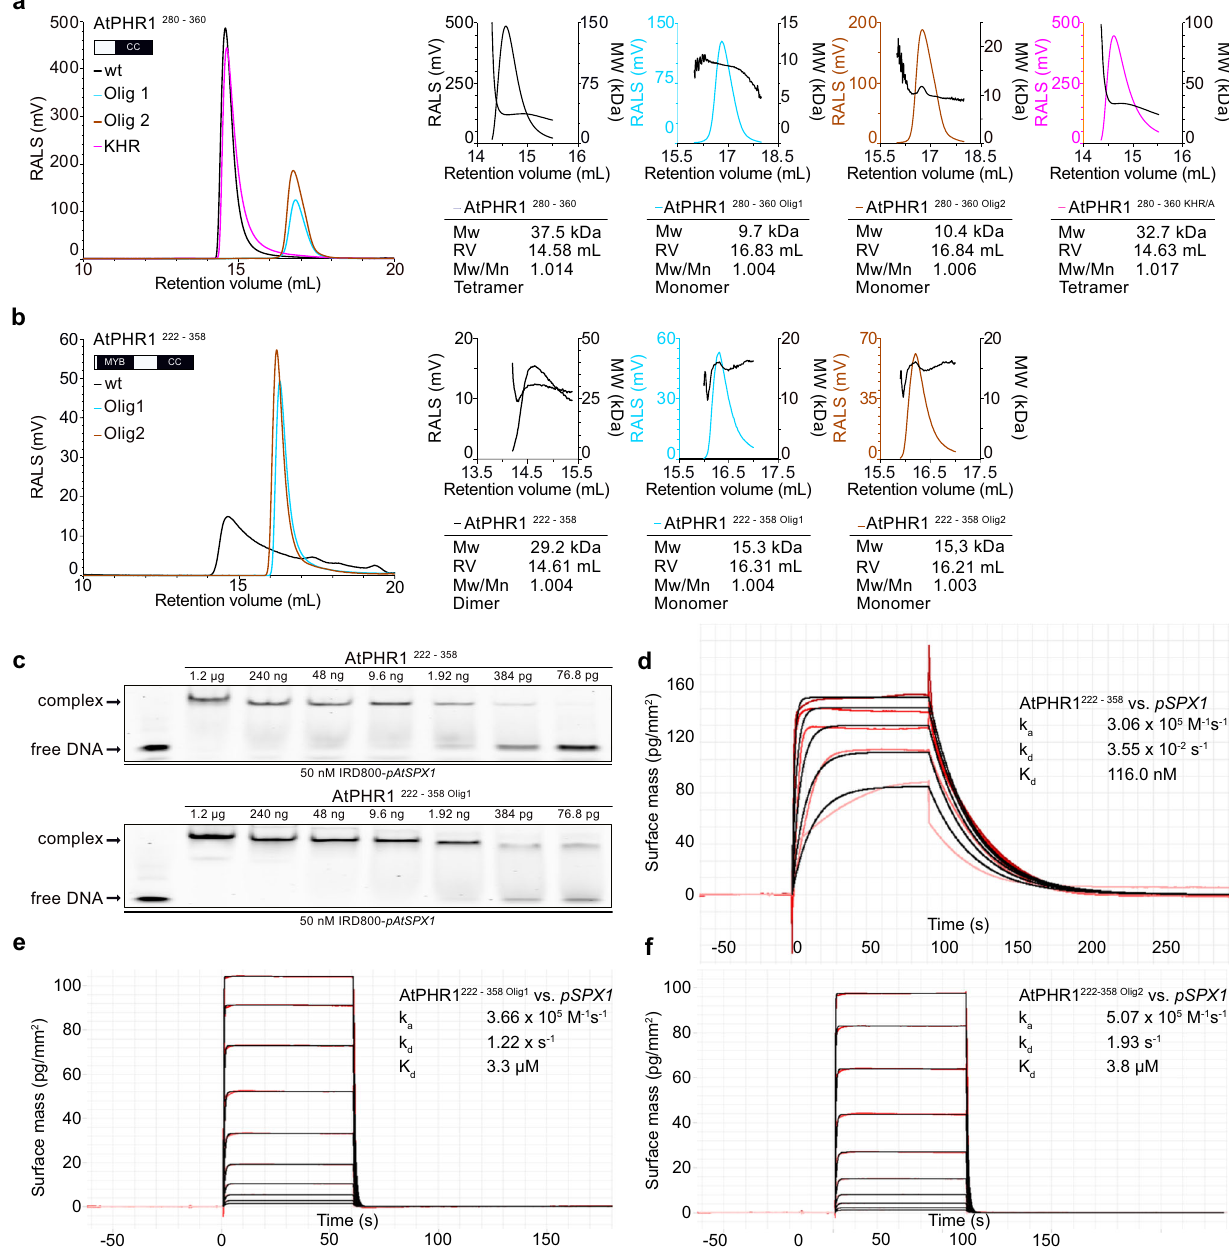
Fig. 2 Mutations in the AtPHR1 coiled-coil domain impair oligomerisation and DNA binding. a Analytical size-exclusion chromatography traces of wild- type AtPHR1 CC (wt, black line), AtPHR1 280 – 360 Olig1 (Olig1, cyan), AtPHR1 280 – 360 Olig2 (Olig2, orange), and of AtPHR1 280 – 360 KHR/A (KHR, magenta). The corresponding right-angle light scattering (RALS) traces are shown alongside, the molecular masses are depicted by a black line. Table summaries provide the molecular weight (Mw), retention volume (RV), dispersity (Mw/Mn), and the derived oligomeric state of the respective sample. b Analysis of AtPHR1 MYB-CC (AtPHR1 222 – 358 ) as described in a . c Qualitative comparison of the interaction of AtPHR1 222 – 358 (upper panel) or AtPHR1 222 – 358 Olig1 (lower panel) binding to IRD800- pAtSPX1 in electrophoretic mobility shift assays. Experiment was performed twice with similar results. d – f Quantitative comparison of the interaction of AtPHR1 222 – 358 , AtPHR1 222 – 358 Olig1 , or AtPHR12 22 – 358 Olig2 with pSPX1 by grating-coupled interferometry (GCI). Sensorgrams show raw data (red lines) and their respective fi ts (black lines). Table summaries provide the derived association rate ( k a ), the dissociation rate ( k d ), and the dissociation constant ( K d